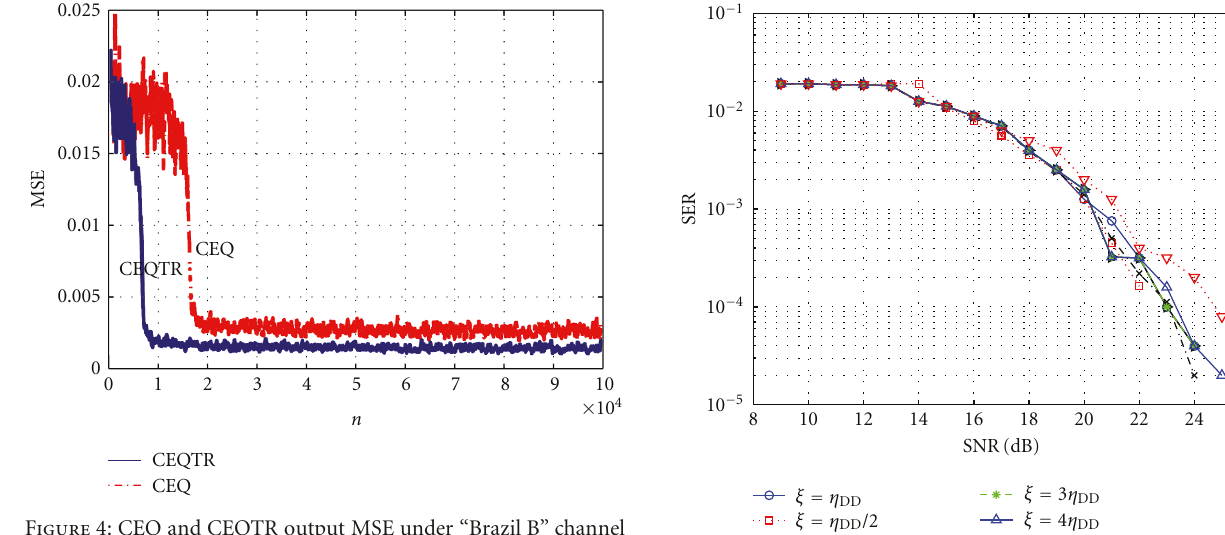
Figure 4: CEQ and CEQTR output MSE under “Brazil B” channel profile, no Doppler rotation applied, SNR = 30dB. L , FIR init, η CMA , and η DD as in Figure 2.